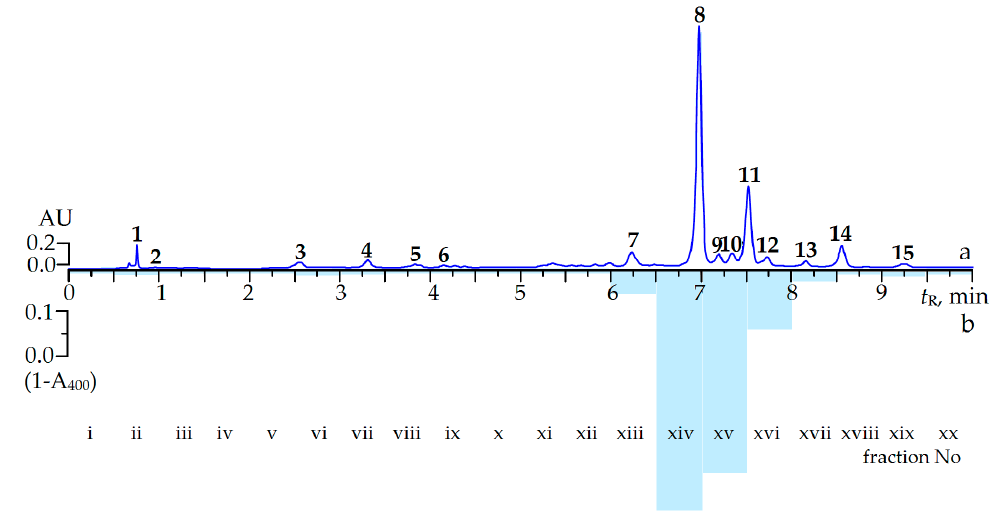
Figure 1. The microcolumn reversed phase HPLC chromatogram of (a) C. palustre extract at 270 nm and (b) (1-A 400 ) values of fraction (i–xx) after post-column derivatization. Compounds: